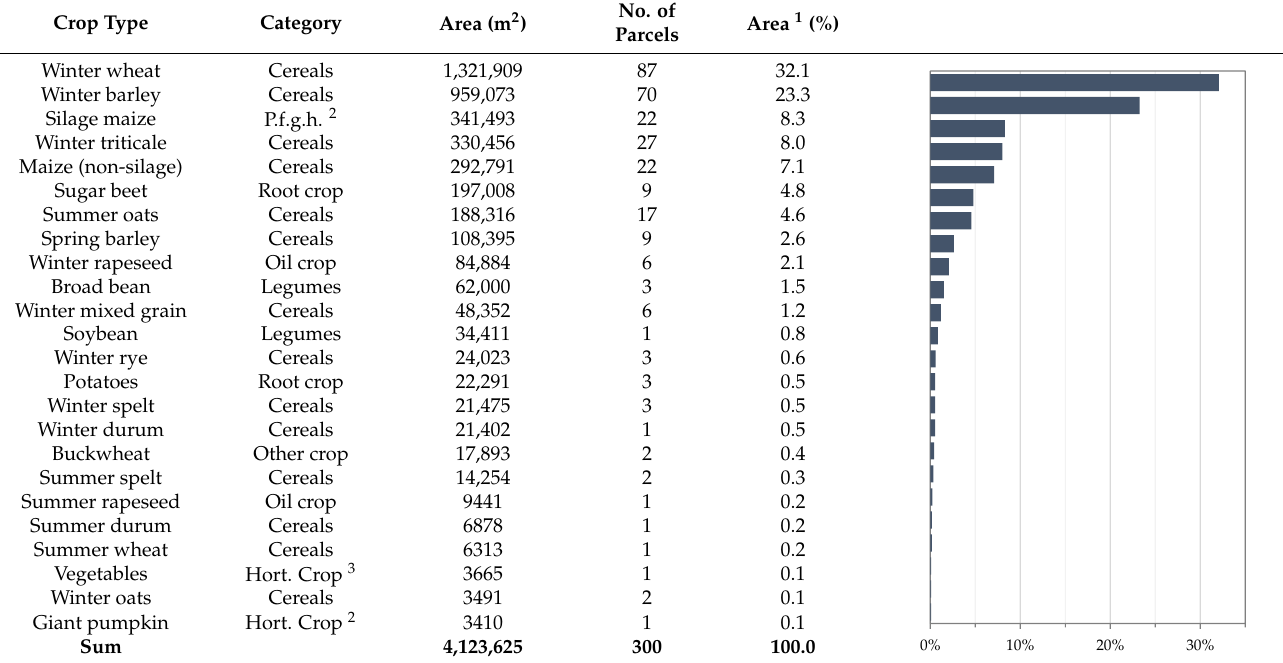
Table 2. Distribution of different crop types in the Fischbach catchment (deviations result from rounding); data source: [40]. Crop Type